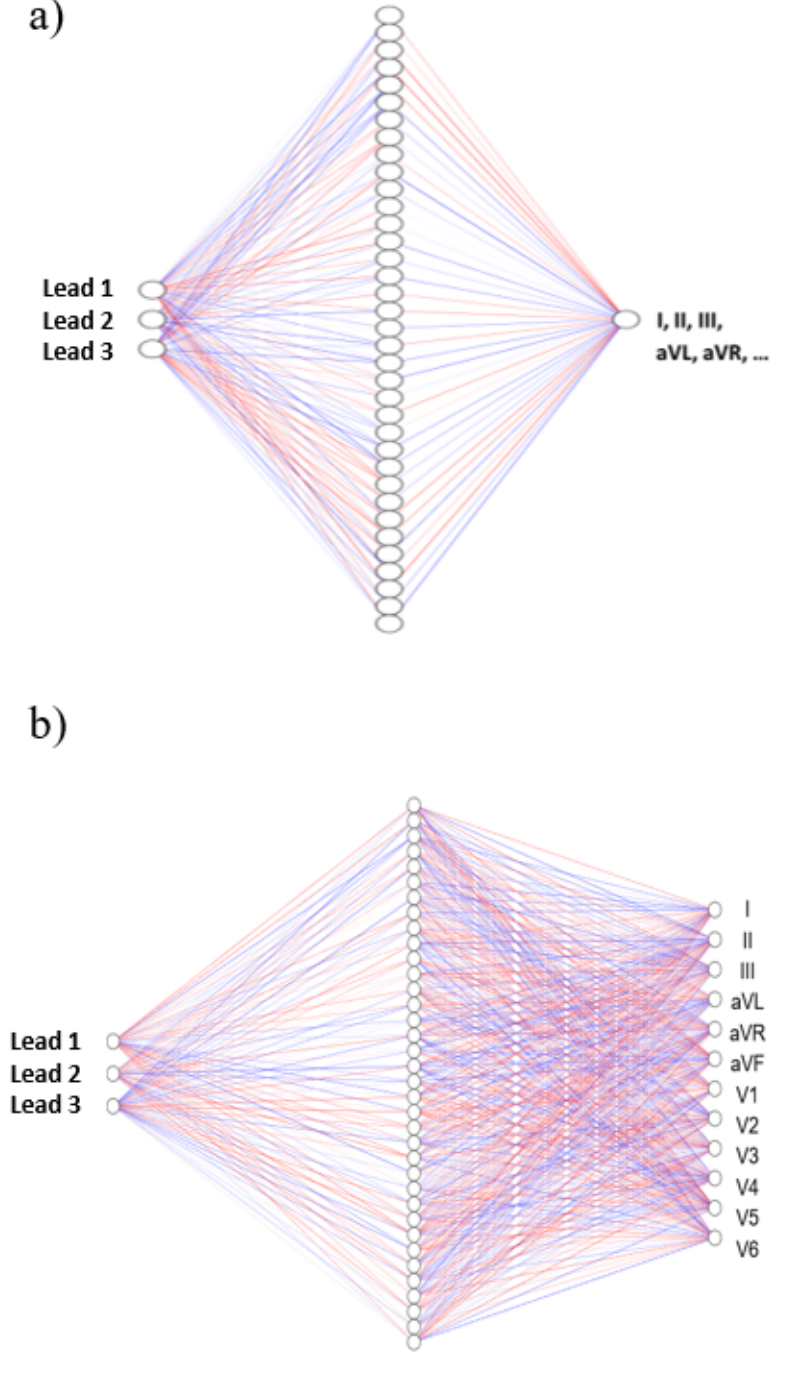
Figure 5. ANN to reconstruct ECG: ( a ) single lead of the Standard 12-Lead system and ( b ) all leads of the Standard 12-Lead System